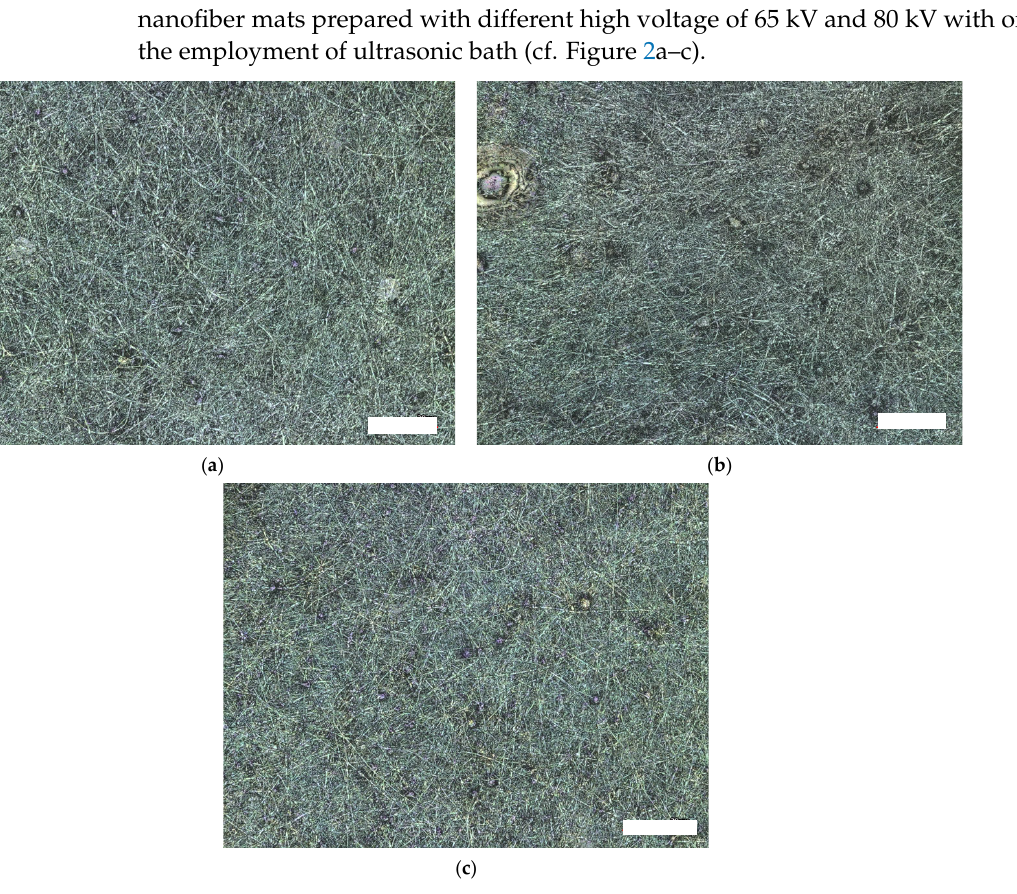
Figure 2. Confocal laser scanning microscope (CLSM) images of the magnetic nanofiber mats: ( a ) 14 wt% PAN with 65 kV voltage and 40 min ultrasonic bath; ( b ) 14 wt% PAN with 80 kV voltage and 40 min ultrasonic bath; ( c ) 14 wt% PAN and 80 kV voltage without ultrasonic bath. Scale bars indicate 20 μ m.